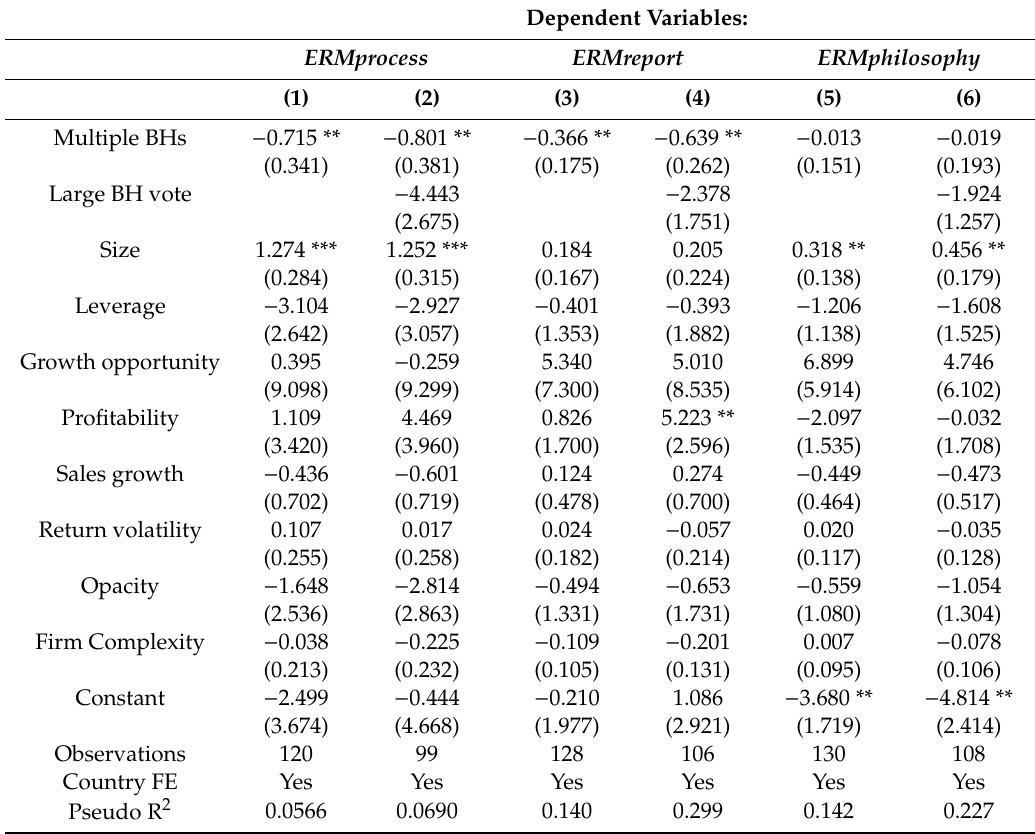
Table 4. Multiple Blockholders and